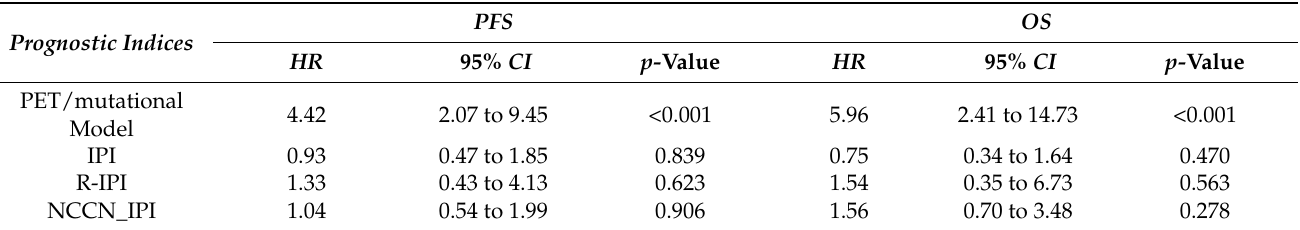
Table 4. Cox regression models for either PFS or OS prediction including the International Prognostic Indices and the integrative PET model derived from the classification tree.